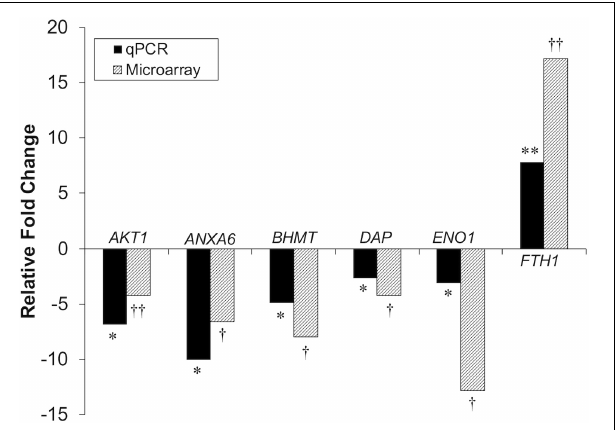
FIGURE 3 | Microarray and qPCR data show similar trends of gene expression in proliferation experiments. Fold change is defined as the change in gene expression in the DAP knockdown samples relative to control samples. Bars below the origin indicate lower expression (down-regulation) of the gene in the DAP knockdown samples; bars above the origin indicate higher expression (up-regulation). * P < 0.05, ** P < 0.01, † FDR < 0.05, and †† FDR < 0.01. AKT1 , Akt1; ANXA6 , Annexin A6; BHMT , Betaine-homosysteine S -methyltransferase; DAP , death-associated protein;